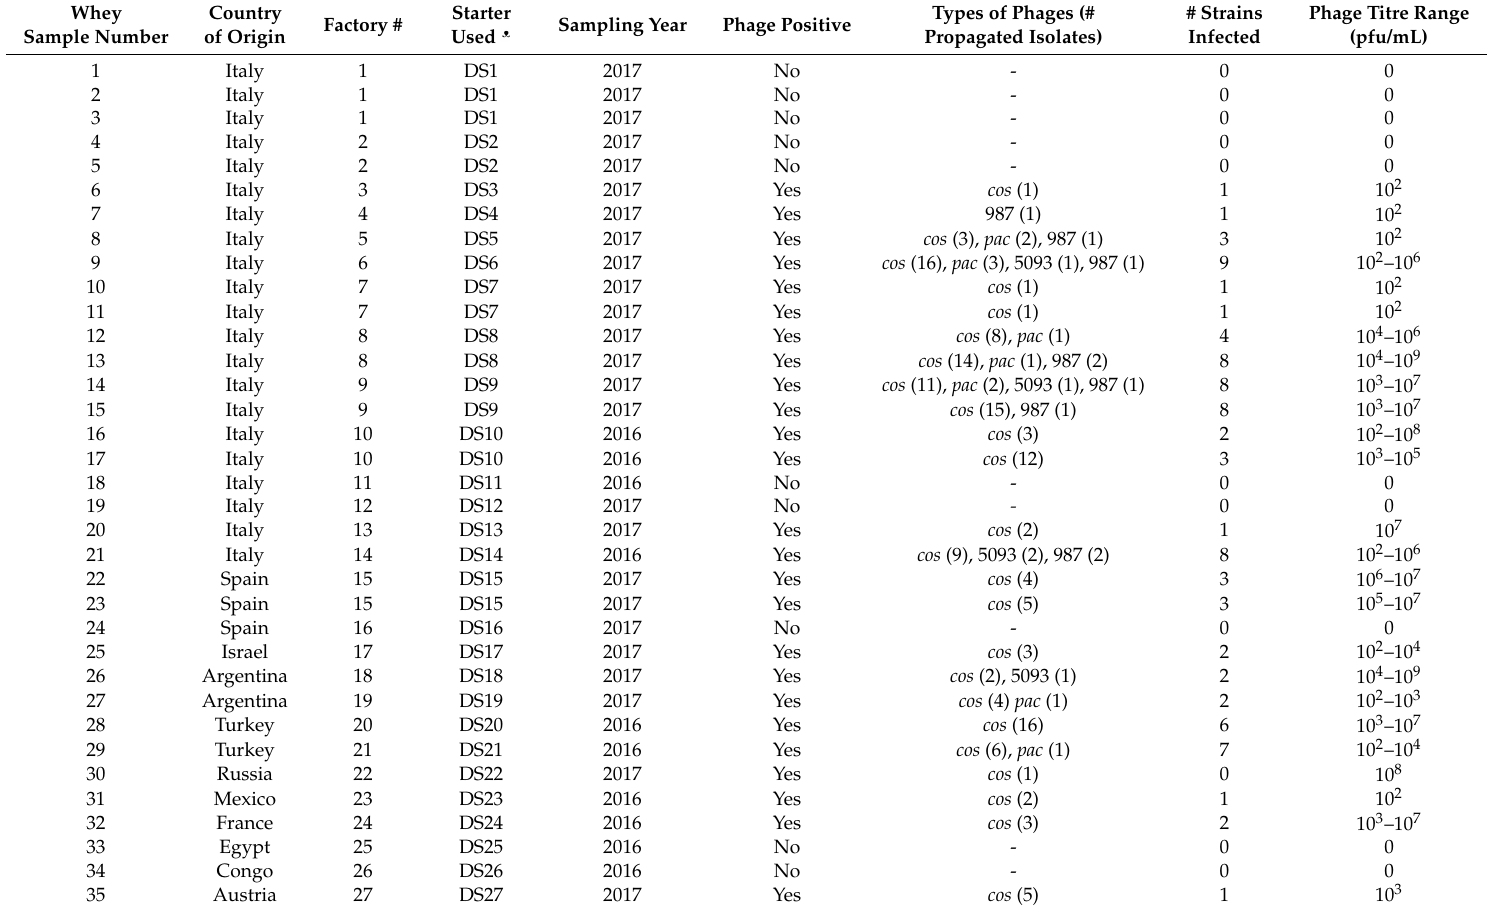
Table 3. Information associated with the samples used in this